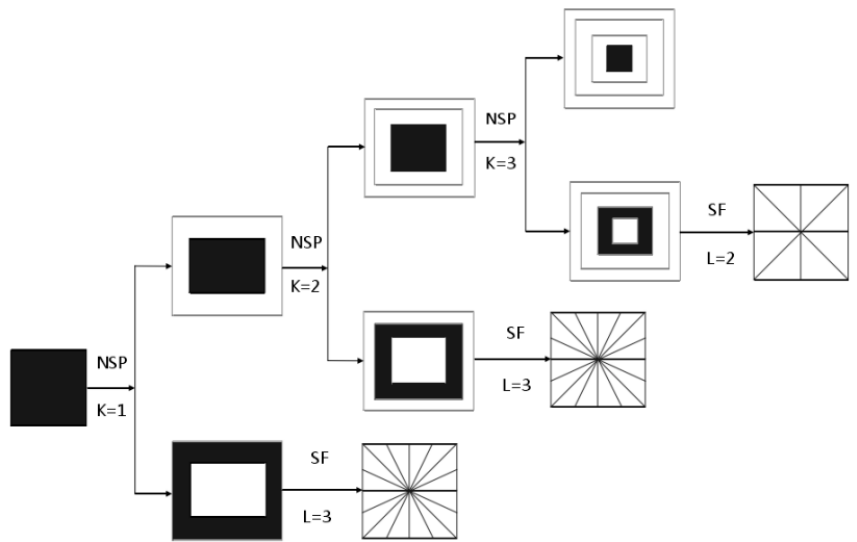
Figure 1. NSST breakdown structure diagram.